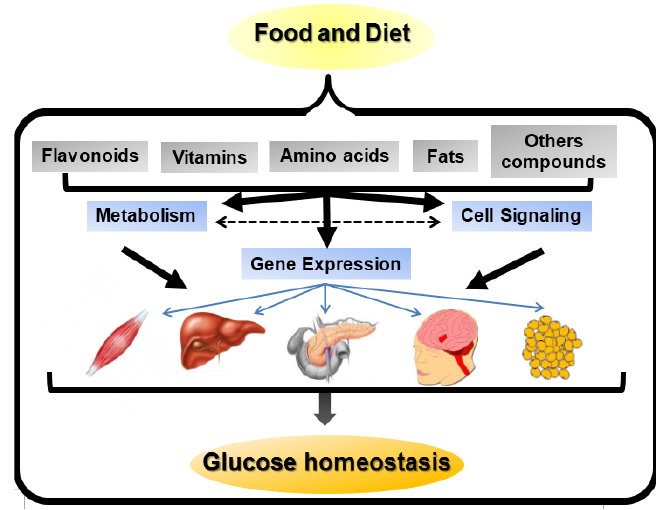
Figure 1. Nutrient-gene expression mechanisms. Nutrients present in food and diet can affect gene expression in a number of ways. They may directly act as ligands for transcription factors and change gene expression. Nutrients may be metabolized by different pathways, thereby modifying the concentration of substrates or intermediates that affect gene expression. Alternatively, the substrates or intermediates may act on or alter cell signaling pathways involved in gene expression. Moreover, nutrients may directly alter signal transduction pathways responsible for modifications in gene expression. Finally, the modifications in the signaling pathways, caused by nutrients, may modulate the metabolism of nutrients affecting gene expression. The modifications in gene expression may affect muscle, liver, pancreatic β cells, hypothalamus and adipose tissue, thereby regulating glucose homeostasis. The effects of these nutrient-gene interactions can be deleterious increasing DM risk and illness progression and complications or protective doing the opposite